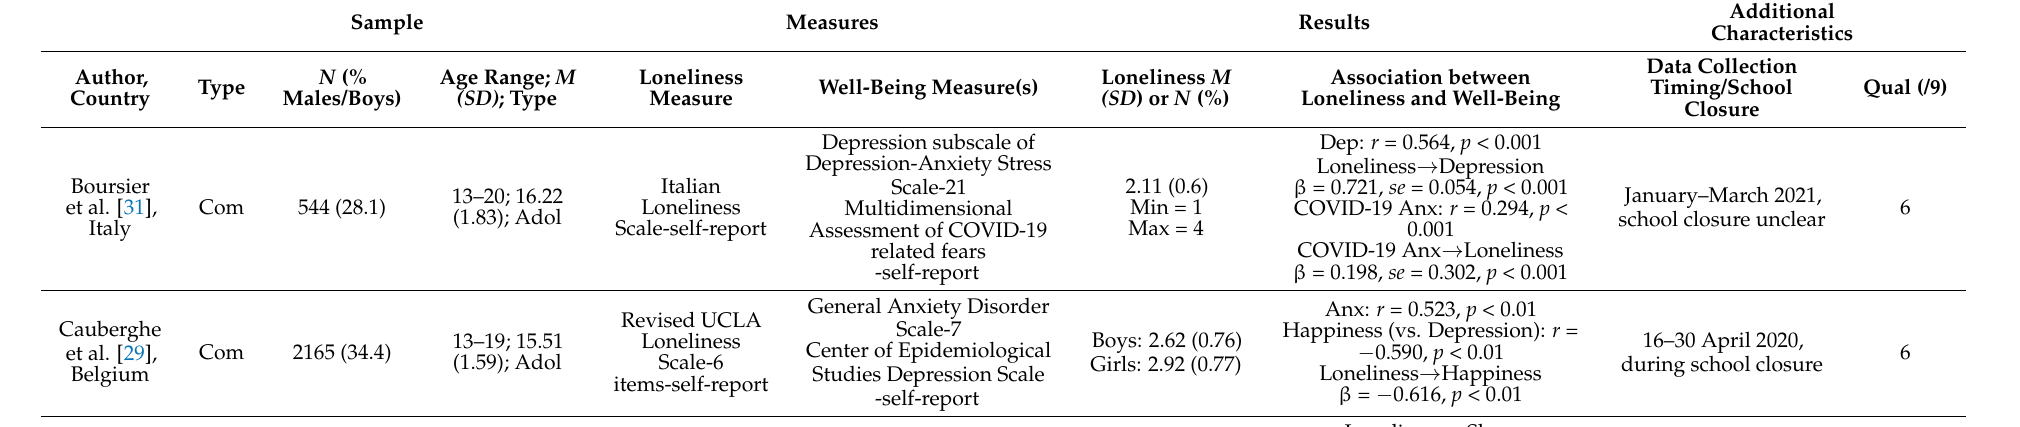
Table 1. Summary of Cross-Sectional